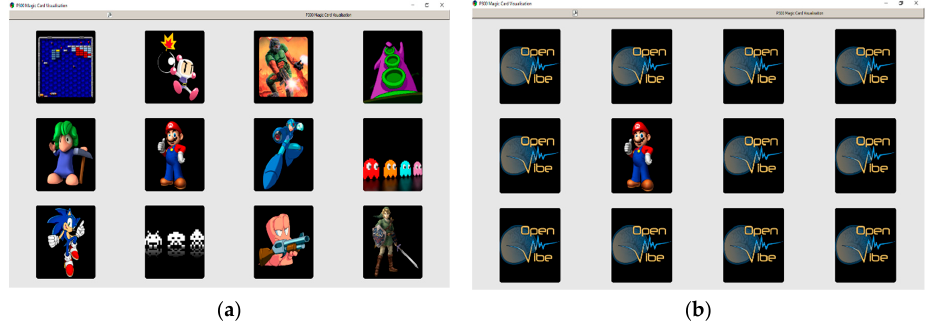
Figure 2. Matrix of images used to obtain P300 evoked potentials: ( a ) At the beginning of the experiment, all the images are displayed; and ( b ) during the development of the experiment, the images are hidden and appear randomly one by one.